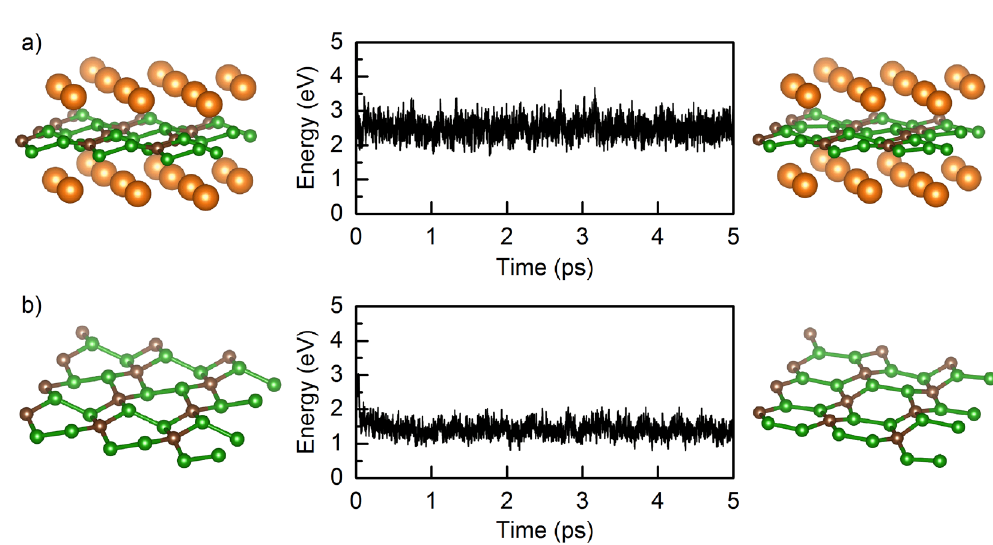
Figure 6. Kinetic energy fluctuation as a function of time and corresponding snapshots before and after simulation for ( a ) fully charged B 2 C monolayer (Mg 2 B 2 C) and ( b ) fully discharged B 2 C monolayer at 300